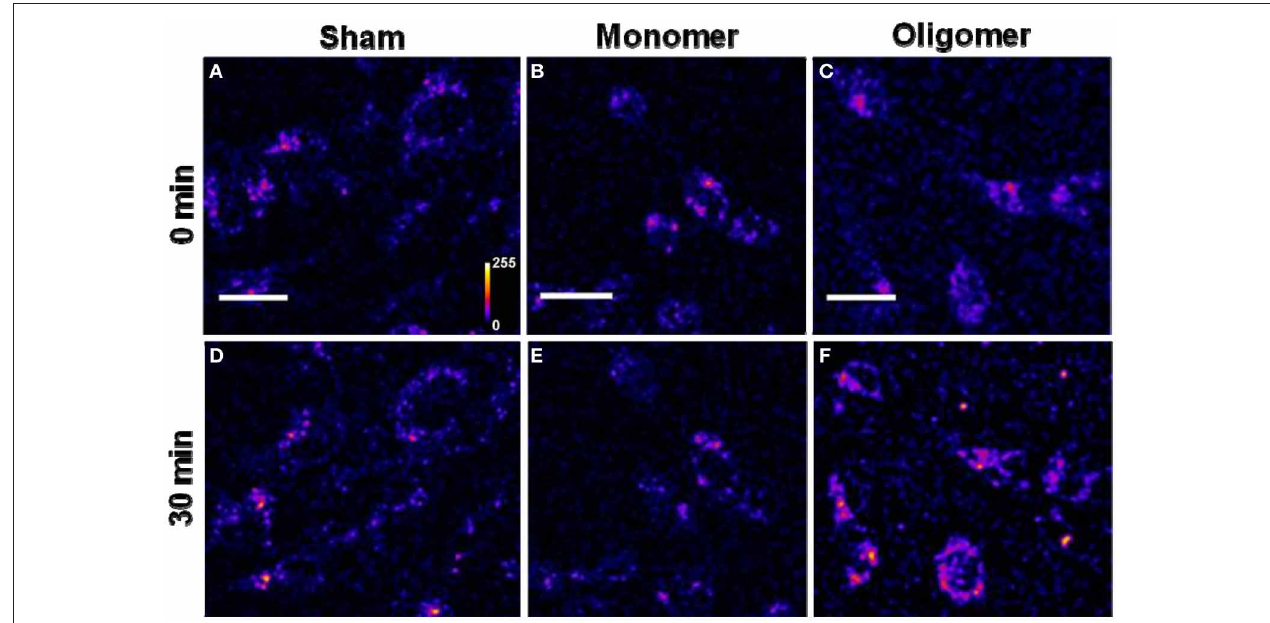
FIGURE 4 | Binding of A β 42 monomers and oligomers to RN46A cell membranes. (A–C) Confocal sections of three sets of cells (excitation 543nm, emission 550–700nm). (D–F) Corresponding sets of cells after